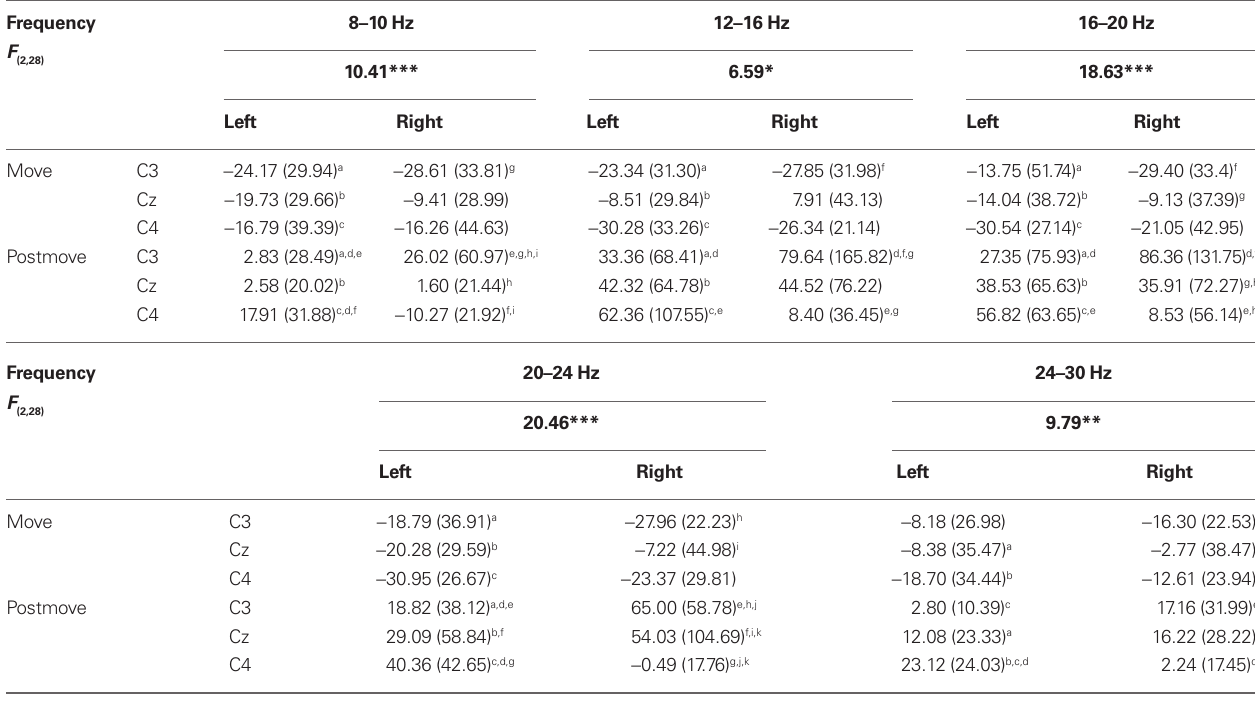
Table 4 | F -values, mean, and SD of erD/erS values for the significant interaction “hand × phase × position” in motor execution task. Frequency